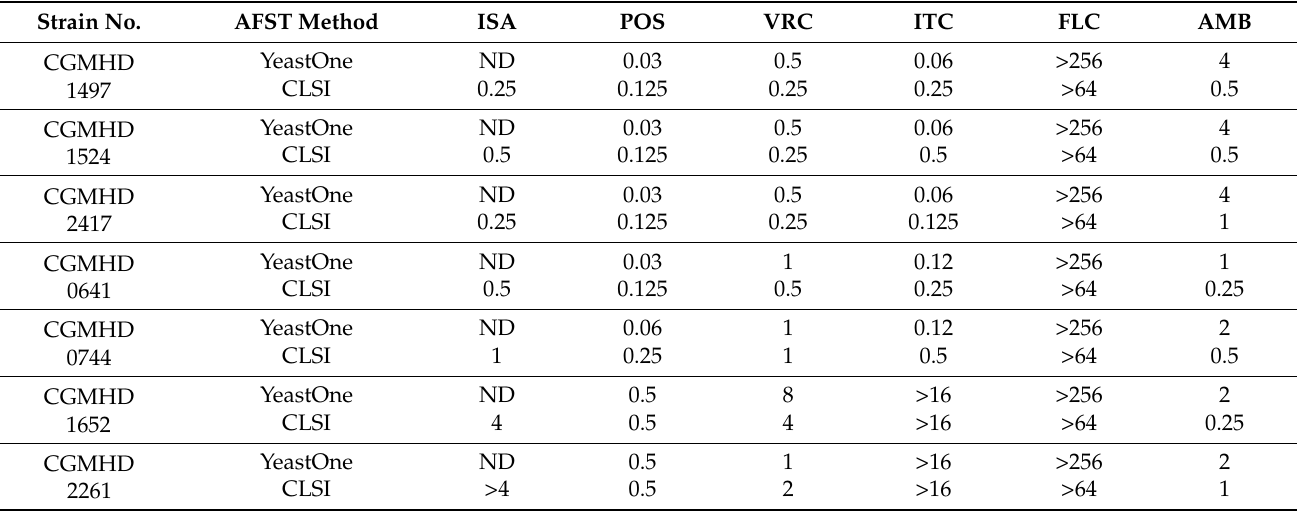
Table 2. The MIC values ( µ g/mL) of different antifungals against seven Aspergillus fumigatus isolates as determined by the YeastOne TM and CLSI